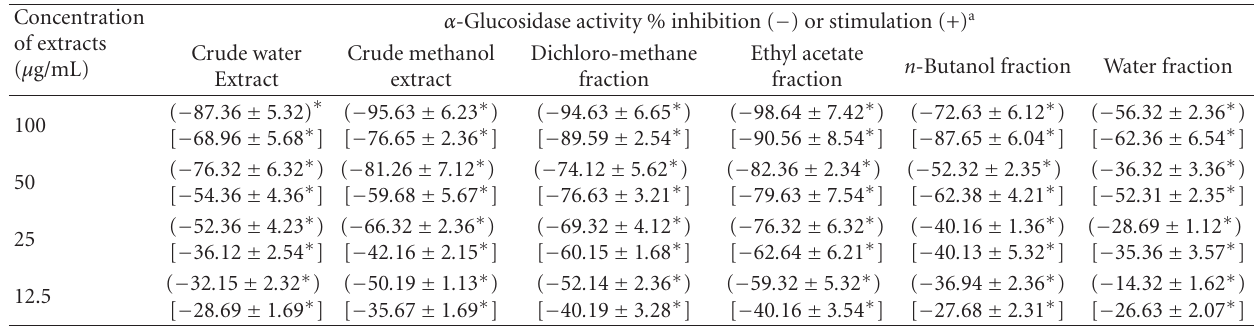
Table 2: E ff ects of AM and MC on α -glucosidase